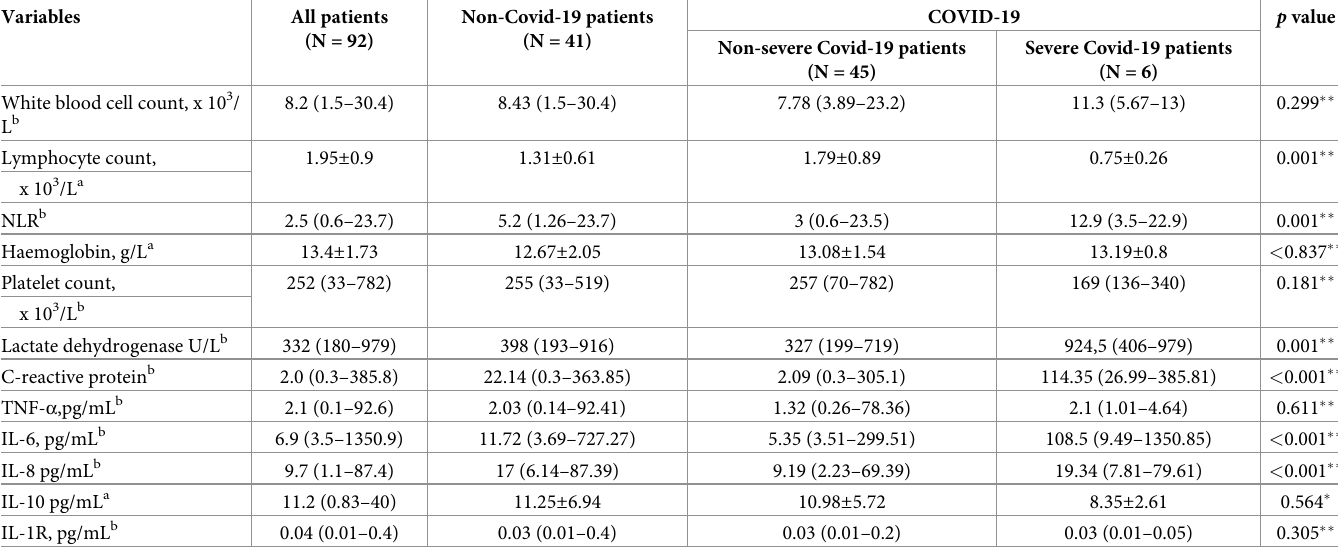
Data are a mean ± SD, b median (IQR), or n/N (%), where N is the total number of patients. p values comparing Non-Covid-19, mild Covid-19 and moderate-severe Covid-19 patients are from ANOVA � and Kruskal-Wallis �� tests. NLR is neutrophil-to-lymphocyte